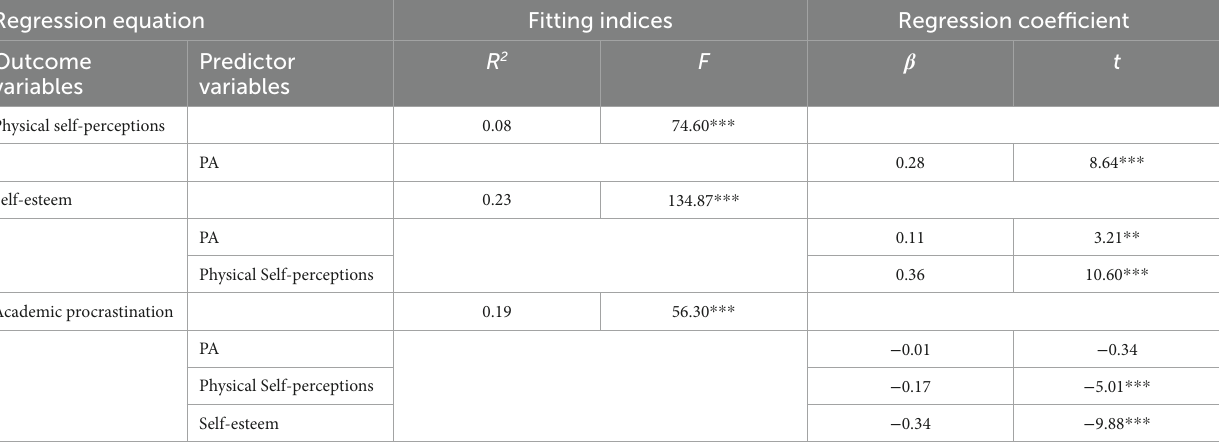
TABLE 2 Results of regression analysis.